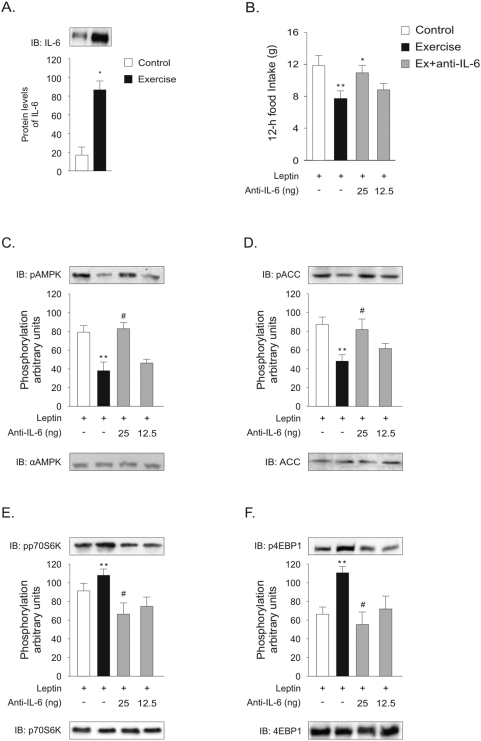
Blockade of leptin induced inhibition of food intake by anti–IL-6 antibody.Hypothalami from rats were prepared as described in Research Design and Methods. (a) Tissue extracts from control and exercised rats were immunoblotted with anti–IL-6 antibody. (b) Leptin was injected intracerebroventricularly in control rats, exercised rats and exercised rats pretreated with anti–IL-6 at the doses indicated, and the animals were immediately exposed to food for a 12-hour period (n = 10–12 animals per group). (c, d, e, f) Representative Western blots of four independent experiments showing hypothalamic lysates from Wistar rats. Phospho-AMPKthr172, threonine-phosphorylated AMPK and total AMPK (c); phospho-ACCser79, serine phosphorylated ACC and total ACC (d); phospho-p70S6Kinasethr389, threonine phosphorylated p70S6Kinase and total p70S6K (e); phospho-4EBP1thr70, threonine phosphorylated 4EBP1 and total 4EBP1 (f). Data are the means±SEM. *p<0.05, vs. control, **p<0.05, vs. control plus leptin, #p<0.05, vs. exercise plus leptin.